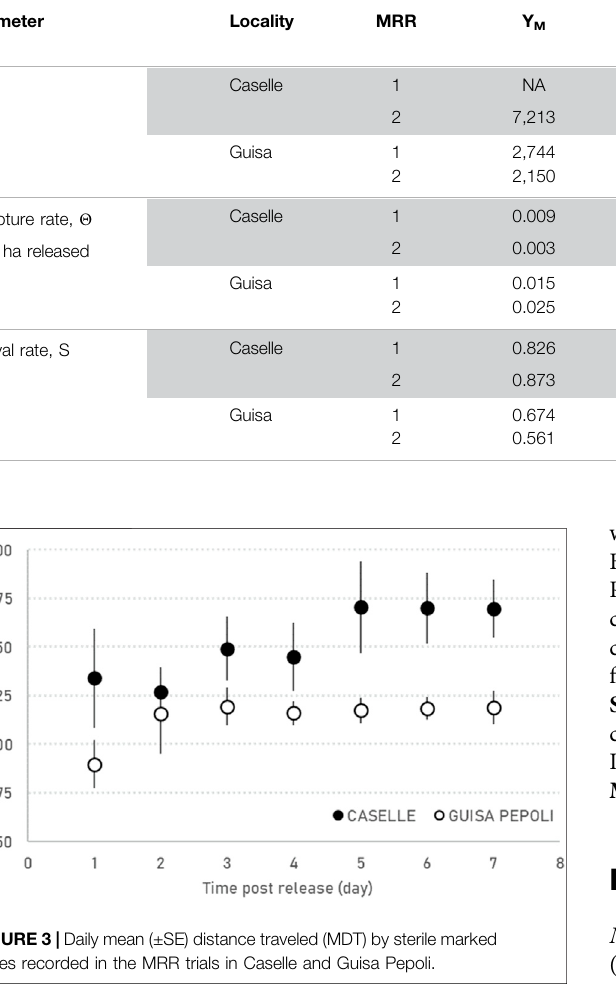
TABLE 2 | ( Continued ) Dispersion and survival parameters registered in the two SIT localities of Caselle and Guisa Pepoli in the fi rst and second MRR trials. MDT , mean distancetraveled; MAX ,maximumdistancetraveled; FR50% and FR90% ,maximum fl ightdistancereachedby50%and90%oftheindividuals; MAD ,meanangleofdispersion (r, length of dispersion; s, angular deviation; a,estimatedmean angle; Z value, Rayleigh ’ s test); Lincoln index - corrected P indicates the population size expressed innumber of male/ha; PDS , probability of daily survival; ALE , average life expectancy (day); Θ , the recapture rate; S , the survival rate. * p < 0.05, ** p < 0.001, *** p <